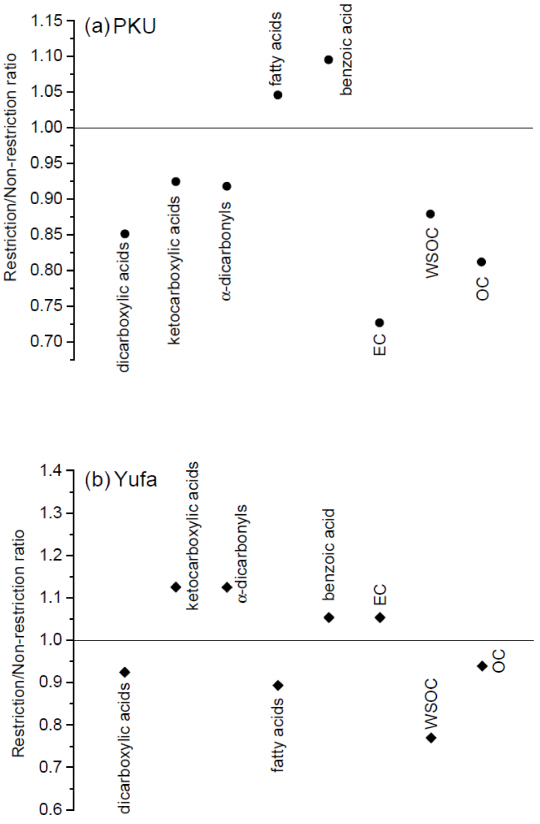
Figure 5. The R / N ratio of particulate compounds observed at PKU (a) and Yufa (b)